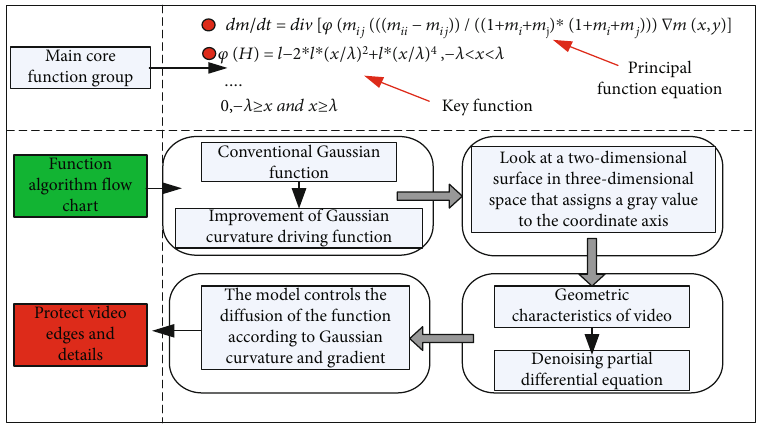
Figure 2: Flow chart of the improved Gaussian curvature driving function